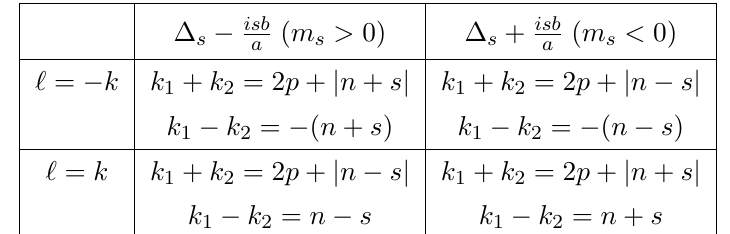
Table 2 . Relabeling positive integers k 1 and k 2 from setting the arguments (cid:1) s (cid:6) isb zeros. The four possible choices of relabeling of k 1 and k 2 come from the four combinations of the signs (cid:27) s and (cid:27) m , and is neatly summarized by (3.13). These rede(cid:12)nitions of k 1 and k 2 produce the ! n = ! (cid:3) conditions displayed in table